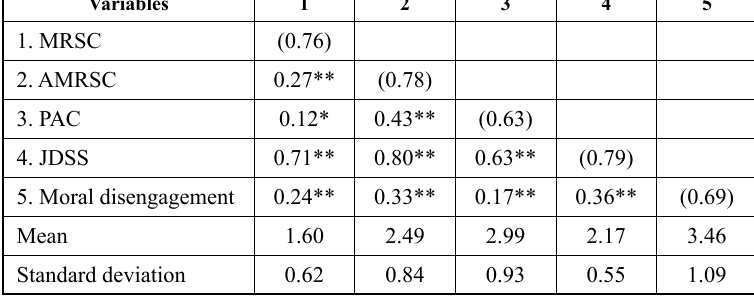
Table 2. correlations, reliability estimates, and descriptive statistics for the JDSS